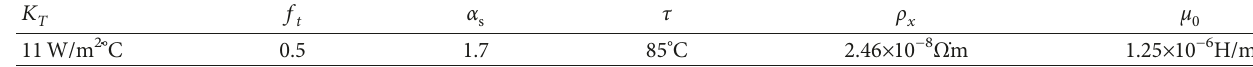
Table 1: Setting of related parameters for optimizing computer.